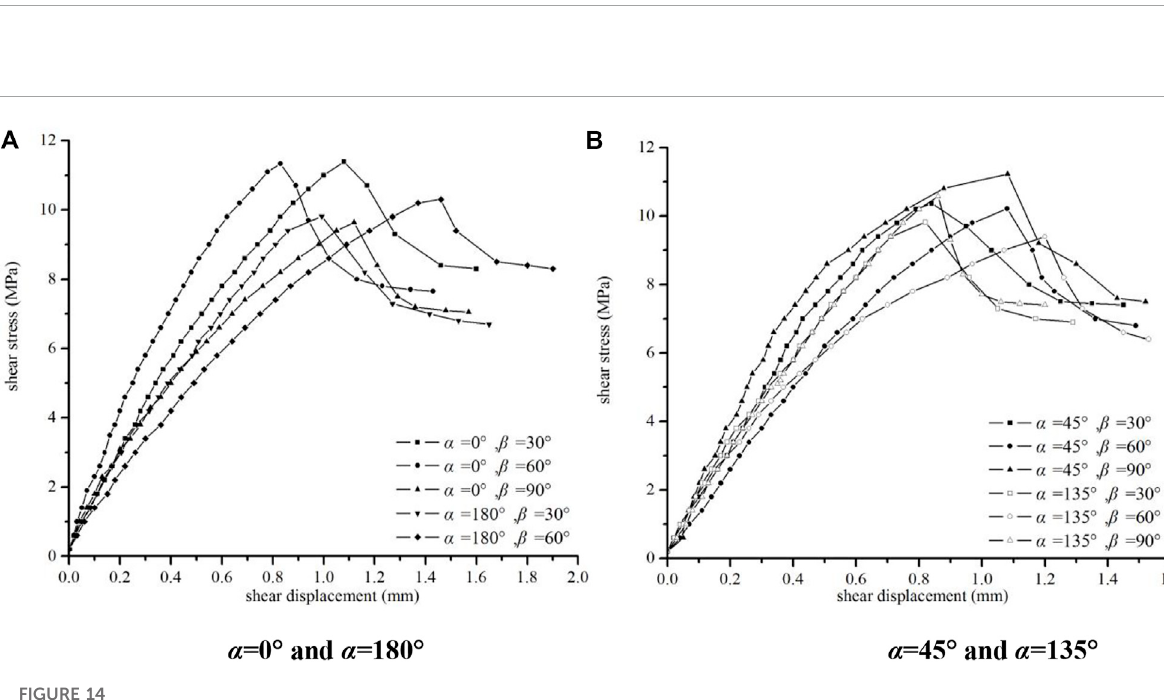
The fractured specimens of α = 135 ° are shown in Figure 12. The fracture surface is signi fi cantly affected by the inclined crack. Separation and displacement are both occurring within the two